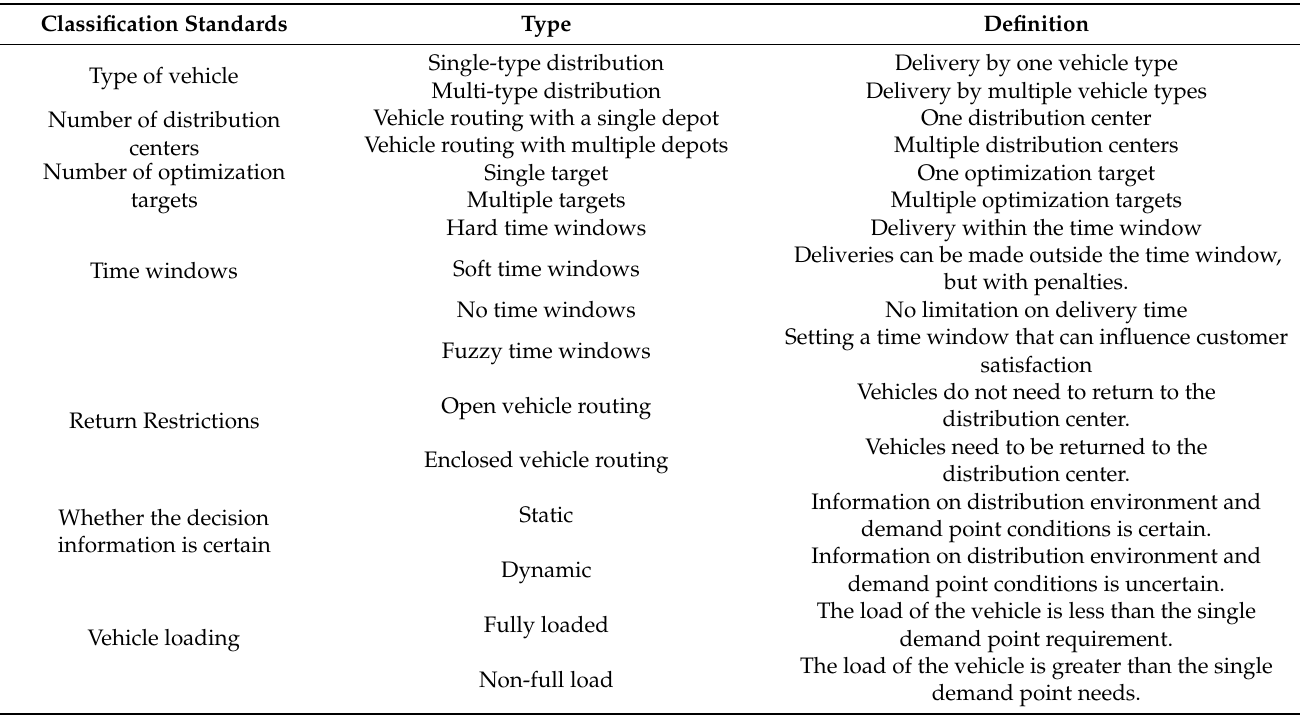
Table 1. Classification of Distribution Route Optimization